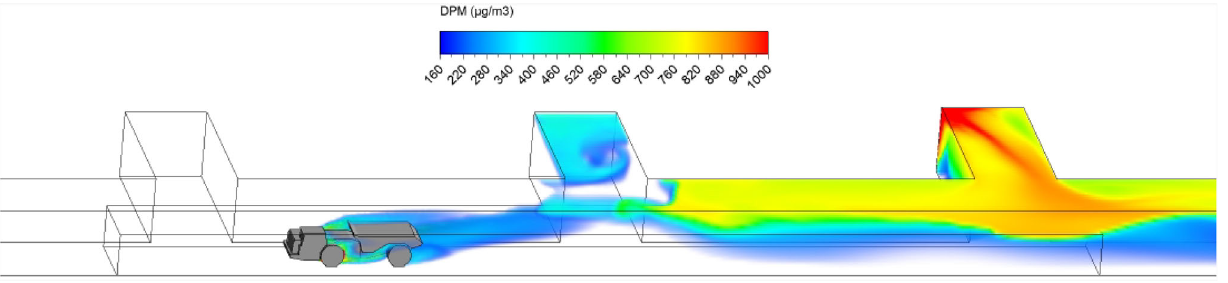
Fig. 12 DPM distributions in scenario 1 during the hauling operation at 225